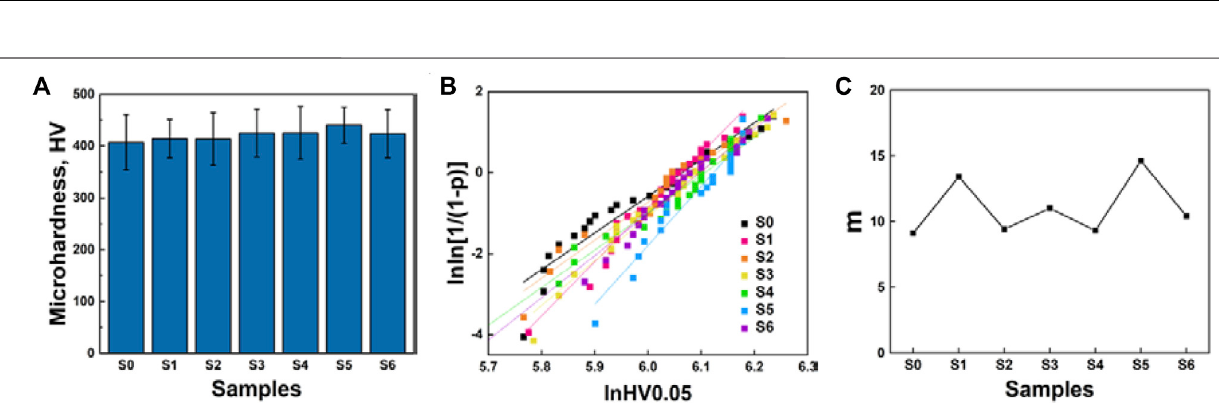
FIGURE 6 | Microhardness of the coatings before and after transient thermal shock tests. (A) The average microhardness of the coatings; (B) Weibull plots of surface microhardness; (C) Weibull modulus of the different samples.